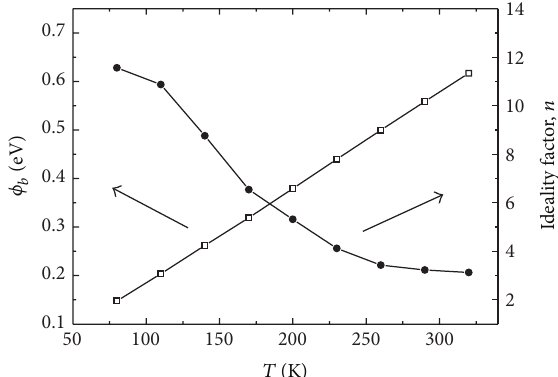
Figure 3: Temperature dependencies of experimental 𝜙 𝑏 and 𝑛 values obtained from current versus voltage characteristics of Al/poly(4-vinyl phenol)/ p -GaAs structure between 80 and 320 K.